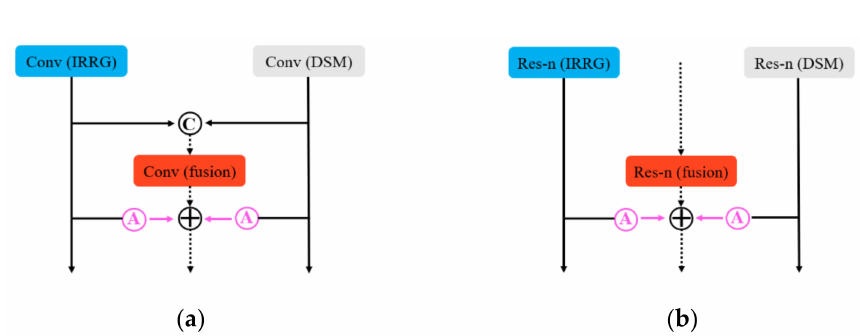
Figure 3. Multi-modality fusion module (MFM). ( a ) MFM-0. ( b ) MFM- n ( n ∈ [1, 3]). In the initial stage, we concatenate feature I 0 from the IRRG data and feature D 0